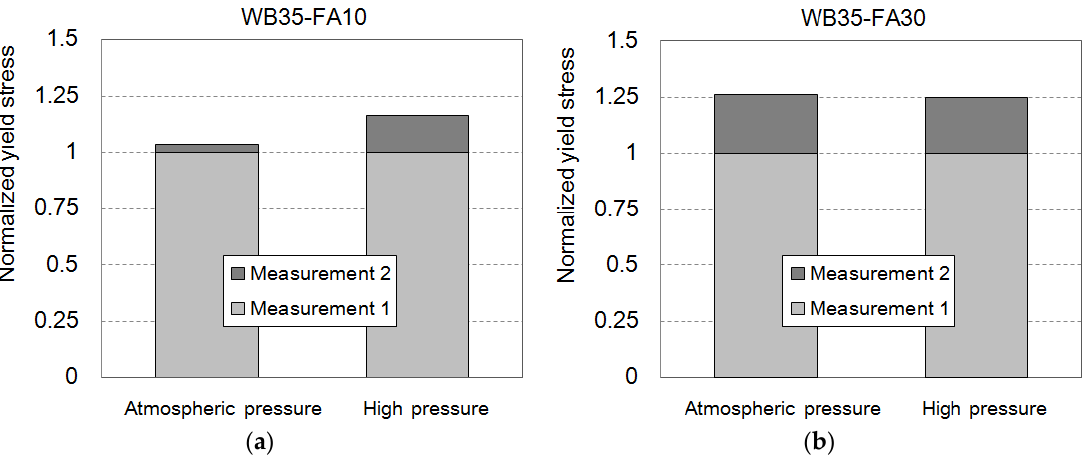
Figure 9. Normalized yield stress of the cement paste with different fly ash replacement of ( a ) 10% and ( b ) 30% under atmospheric pressure and high pressure.